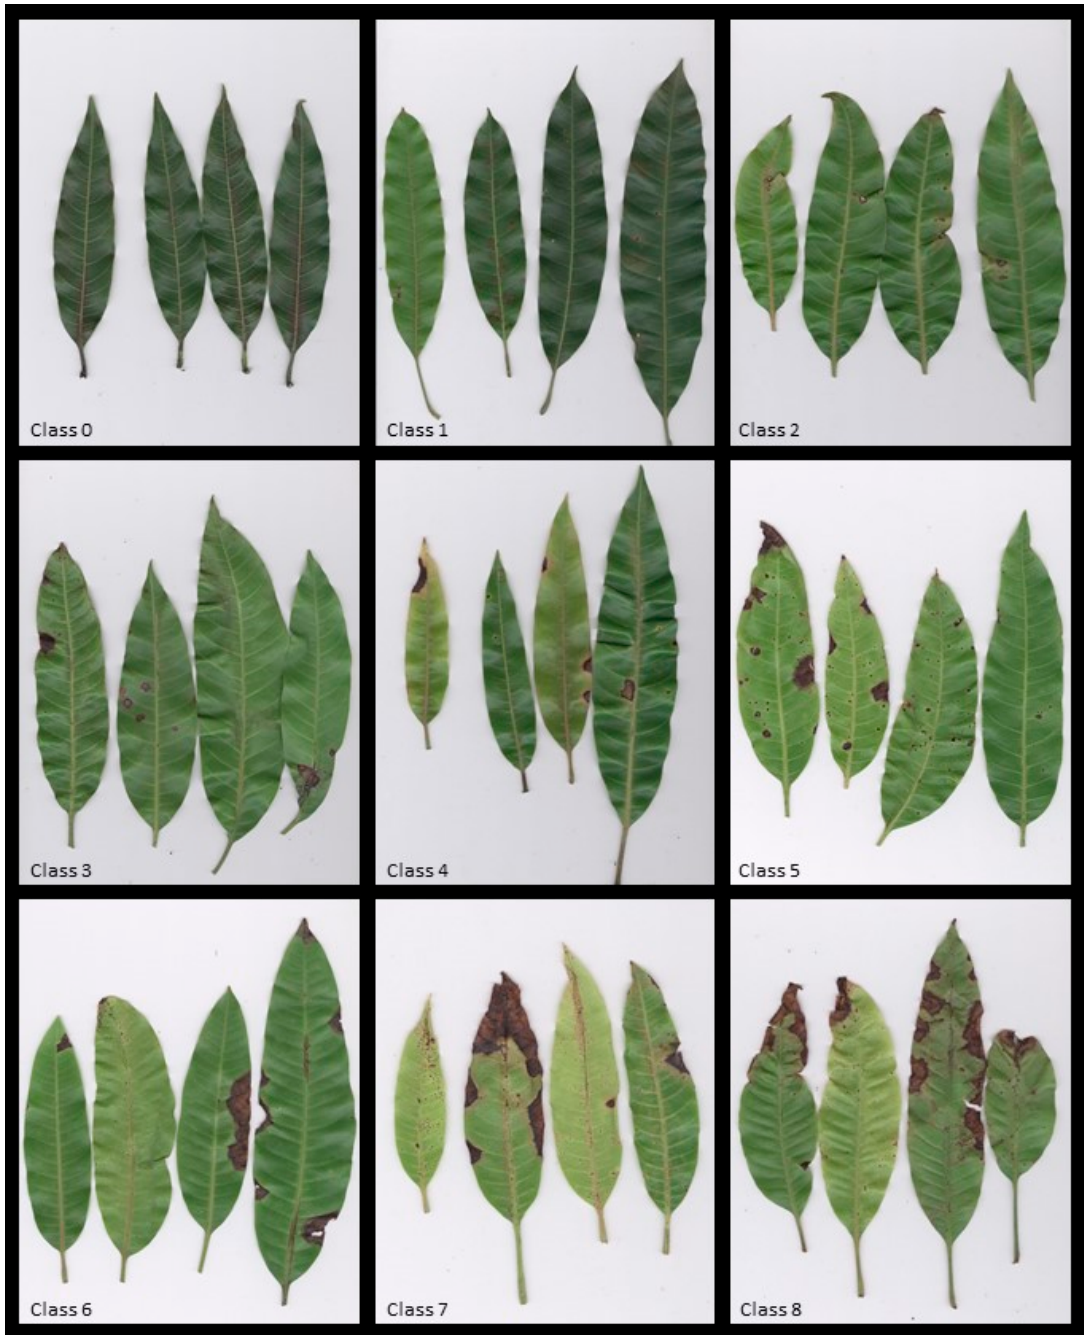
Figure 3. Nine (0-to-8) of total (13) disease classes detected within empirical scale adopted to evaluate severity of leaf infections caused by C. asianum during susceptibility mango evaluation at the Sementeira Farm, Universidade Federal de Viçosa (A–E).